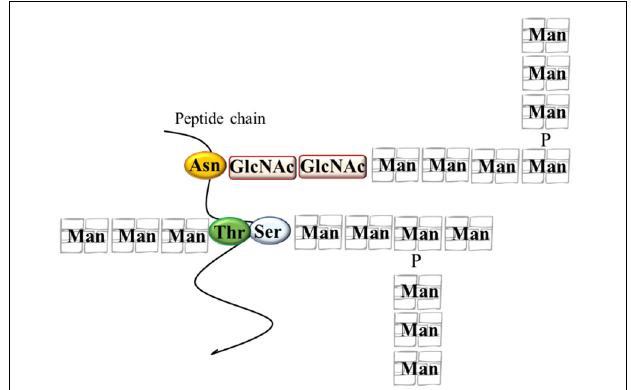
FIGURE 2 | Some structural characteristics of mannoproteins. Asn, asparagine; GlcNAc, N-acetylglucosamine; Man, mannose; P, phosphate; Ser, serine; Thr,